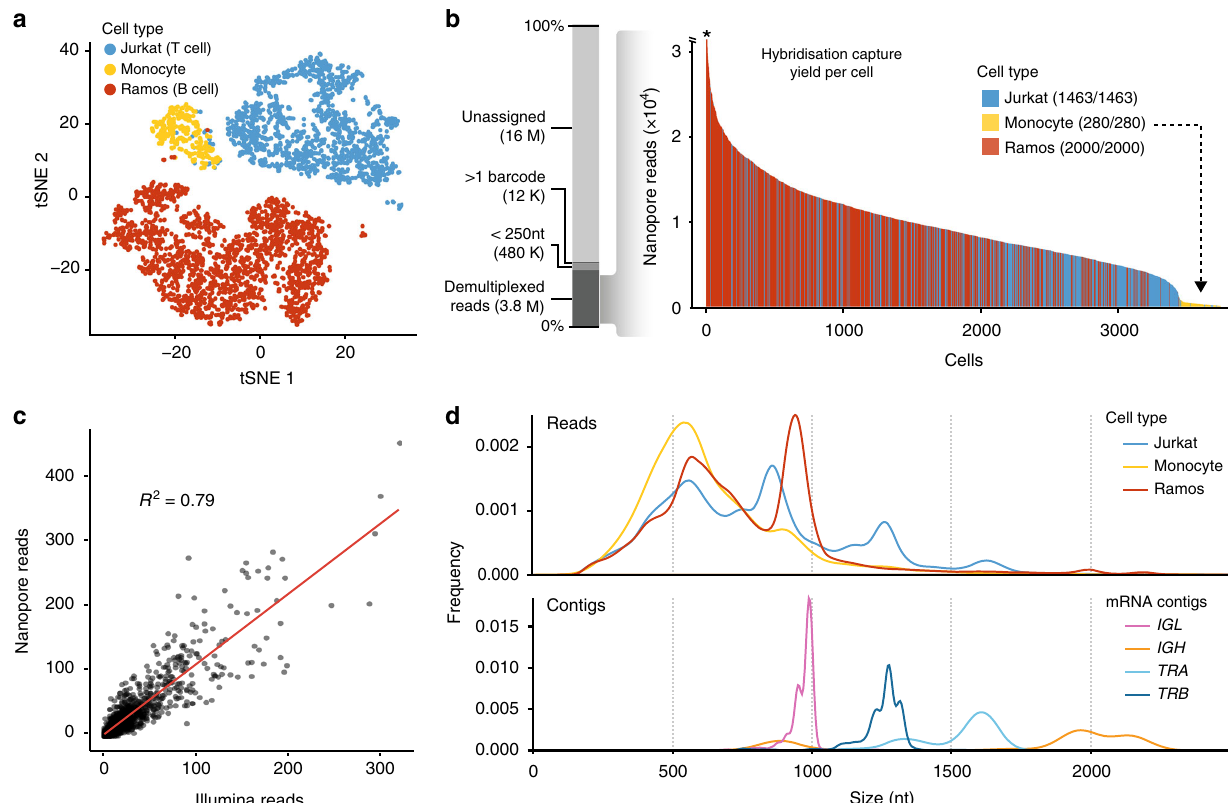
Fig. 2 Short-read and targeted long-read single cell sequencing of immortalised B and T cell lines. a T-distributed stochastic neighbour embedding (t-SNE) analysis of single cells generated from short-read sequencing data (number of cells: Jurkat = 1463; Ramos = 2000; monocytes = 280). b Demultiplexing statistics for nanopore sequencing reads following targeted capture. Each bar corresponds to the number of nanopore reads per cell barcode identi fi ed with short-read sequencing using exact sequence matching. Asterix indicates one cell with over 6000 reads. The number of recovered cell barcodes is shown next to each cell type. “ > 1 barcode ” refers to more than one cell barcode found in a single read and “ < 250 nt ” refers to any read shorter than 250 nt. c Correlation between Illumina read counts and Oxford Nanopore read counts for T-cell receptor alpha constant gene ( TRAC ). Each point represents an individual Jurkat cell ( n = 472). Pearson correlation = 0.79. d Nanopore read length distribution of demultiplexed reads assigned to each cell type (top panel) compared to the length distribution of assembled contigs that have been assigned a productive receptor chain (bottom panel). Predicted lengths (nt) of mRNA transcripts: Jurkat TRA , 1552 nt; Jurkat TRB , 1,259 nt; Ramos IGH (secreted exons), 1485 nt, Ramos IGH (membrane exons), 1683 nt; Ramos